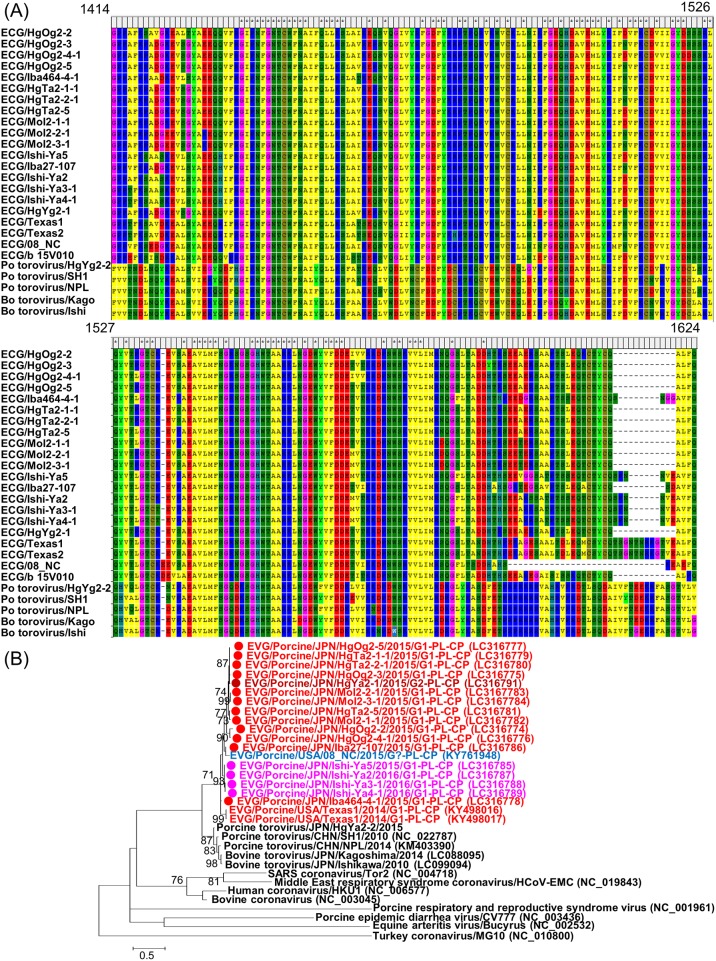
Amino acid (aa) sequence comparison of EV-G PL-CP with that of torovirus PL-CP.(A) Alignment of aa sequences of EV-G PL-CP inserted between regions 2C and 3A with PL-CPs of porcine torovirus and bovine torovirus. (B) Phylogenetic analyses based on aa sequences of EV-G PL-CP and PL-CP of nidoviruses including toroviruses. Phylogenetic trees that were constructed by the maximum likelihood method in MEGA 5.22 with bootstrap values (1000 replicates) above 70 are shown. The scale bar indicates nucleotide substitutions per site. ● denotes EV-G strains detected in this study.